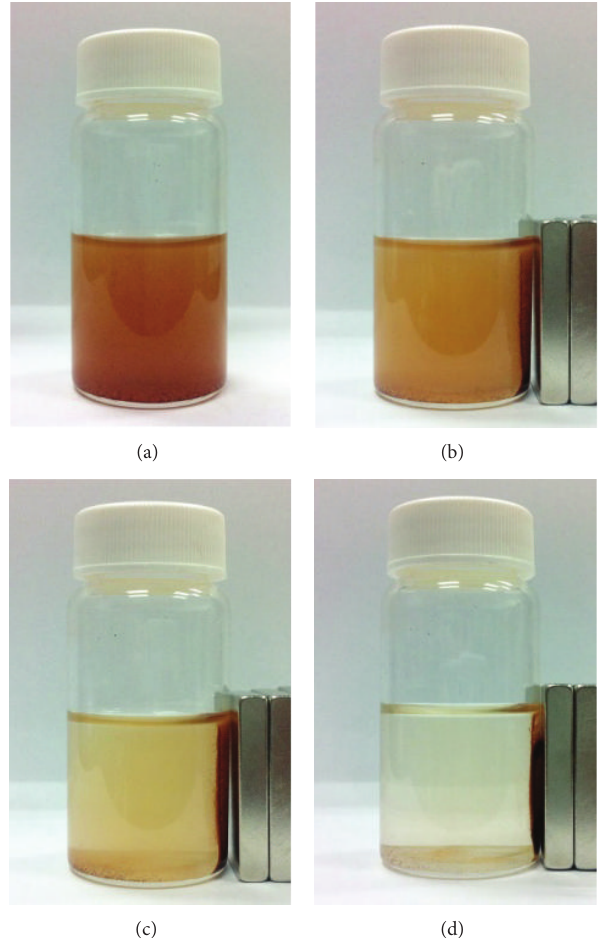
Figure 8: Photographs of Ag-TiO 2 /Fe 3 O 4 dispersed in water after sonication (a) along with its response to the presence of magnet at 10 seconds (b), 1 minute (c), and 5 minutes